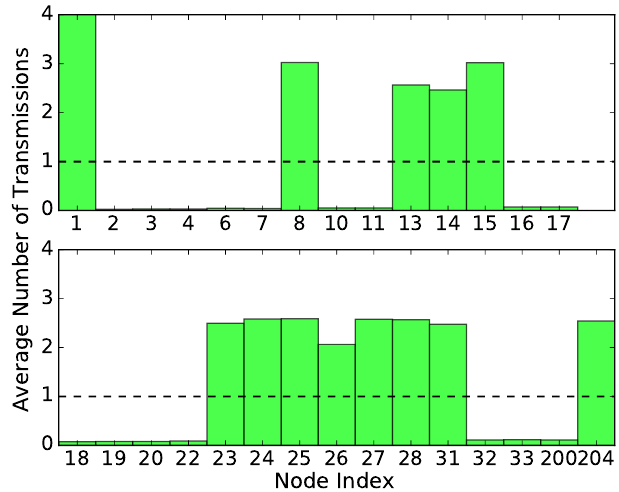
Figure 10. Average number of transmissions with node 1 as initiator and 0 dBm transmission power. The dotted line shows the overall average number of transmissions. As LiM starts with N equal to 5, and progressively determines N, the average value of N in each node is not constant. After the learning phase, LiM eventually obtains an average N equal to 1.